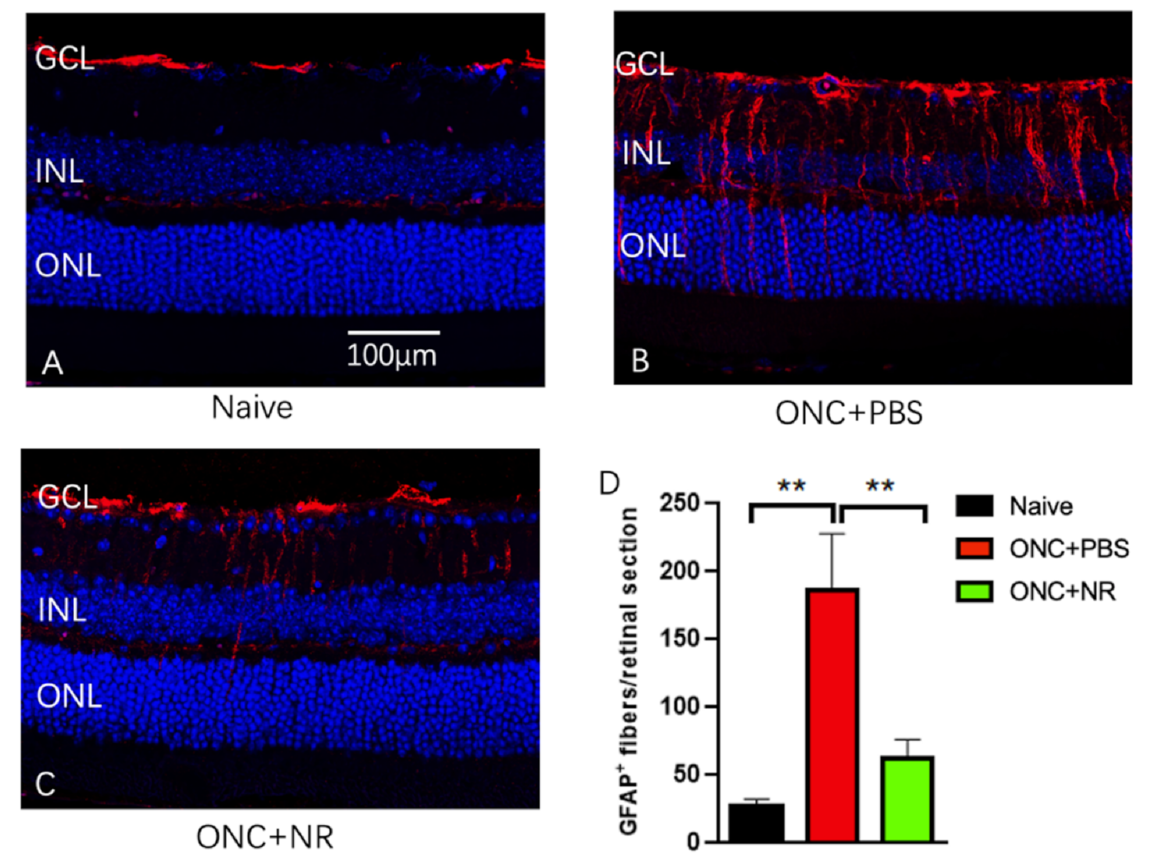
Figure 4. NR treatment prevents GFAP accumulating after ONC. Both PBS- and NR-treated mice underwent ONC and were euthanized at 3 days after ONC. ( A – C ). Representative morphologic images of each group; red is GFAP immunofluorescence signal and blue is DAPI staining. ( D ). GFAP-positive fibers fully penetrating into the INL were counted across the entire retina. NR-treated mice (green bar) exhibited significantly less GFAP signals compared with the PBS-treated group (red bar). GCL: ganglion cell layer, INL: inner nuclear layer, ONL: outer nuclear layer. ** p < 0.01 vs. other two groups, by one-way ANOVA with Newman-Keuls multiple comparisons post hoc test. N = 6 mice per group. Error bars represent SEM. Scale bar = 100 µ